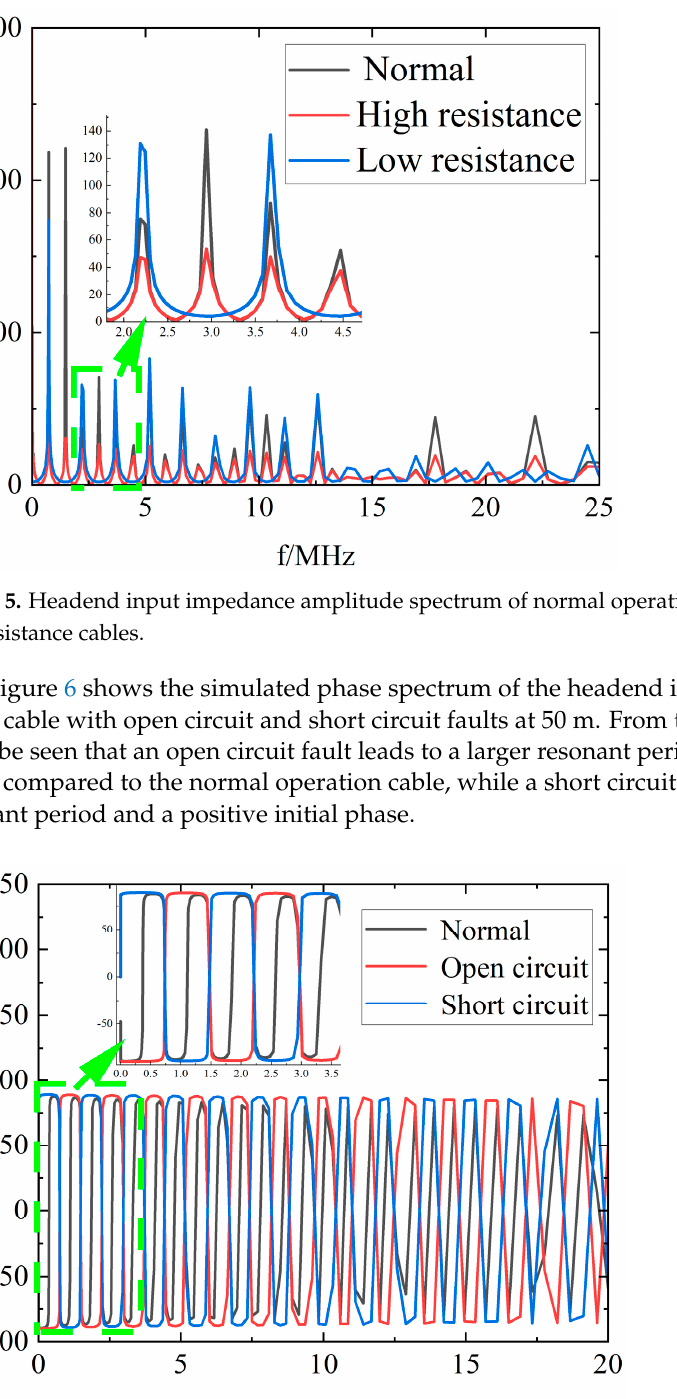
10 of 17 Figure 4. Headend input impedance amplitude spectrum of normal operation, open circuit, and short circuit cables.